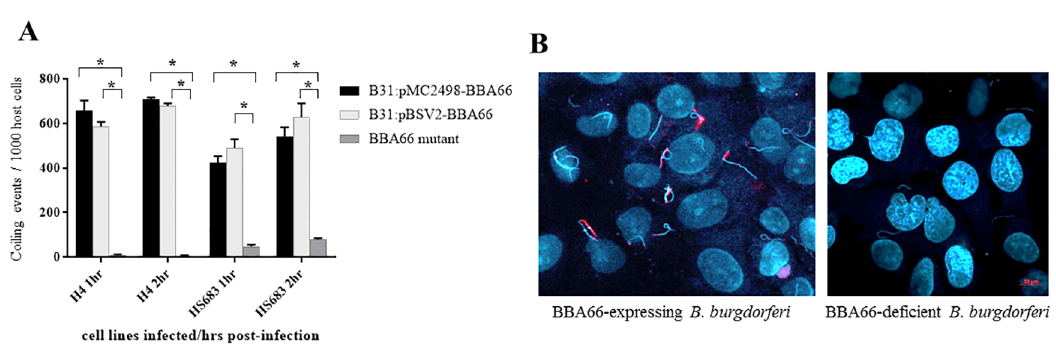
Fig 5. BBA66 knockout mutant strain demonstrates reduced coiling phagocytosis compared to BBA66-expressing strains. A) Bars represent number of coiling events per 1000 host cells. Coiling event is defined as a host cell with a Daam1-stained pseudopod coiling around a B . burgdorferi cell. Asterisks denote P-value < 0.001 by Two-way ANOVA Tukeys’s multiple comparisons test. Graphs represent the mean of all experiments. B) Representative field of H4 cell infection at 2 hrs post-incubation with B31: pMC2498-BBA66 (left panel) and with BBA66 knockout mutant strain (right panel). Daam1 stained red and B . burgdorferi and host cell nucleus stain blue by DAPI.